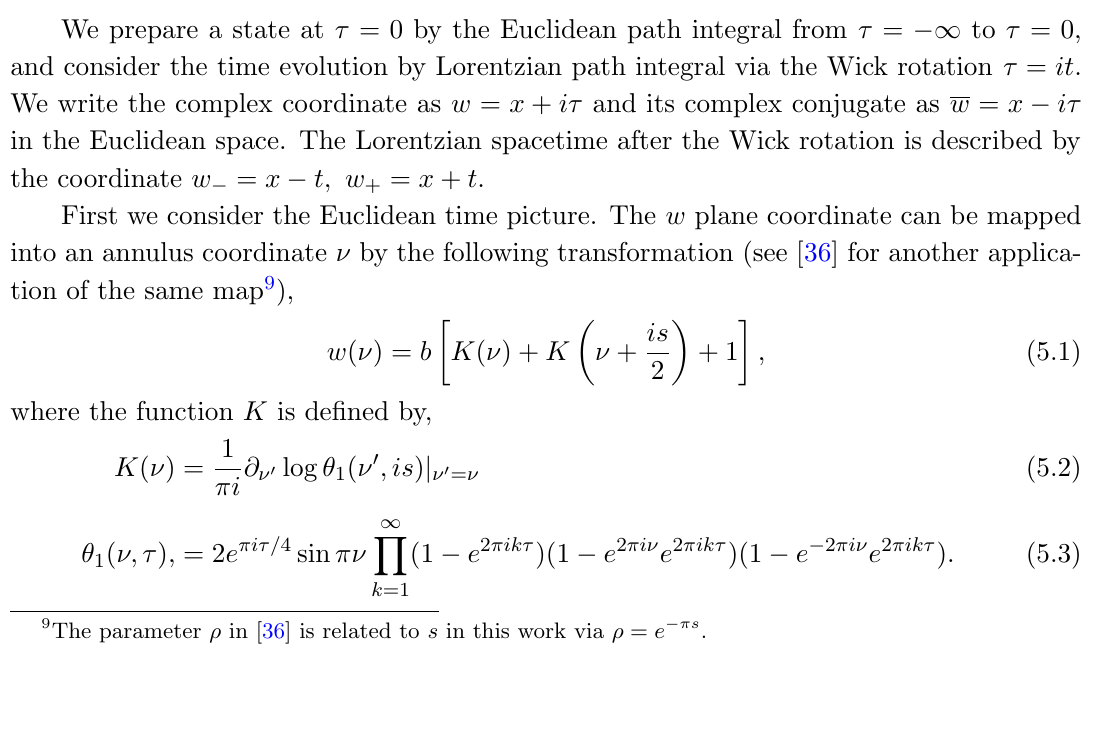
Figure 30 . The left (cid:12)gure describes Euclidean spacetime for double splitting quench. There are two vertical boundaries at b + i(cid:28) ( a < (cid:28) < a ), which means splitting quench at (cid:6) (cid:0) vertical boundaries correspond to splitting 1 dimensional system. a is cuto(cid:11) for quench. The right (cid:12)gure is the annulus (cid:23) coordinate which is de(cid:12)ned by equation